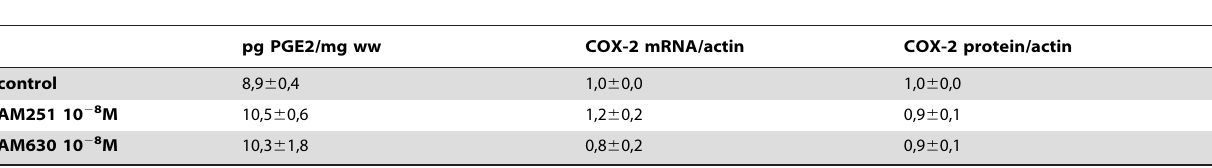
Table 6. Effect of cannabinoid receptors’ antagonists on the production of PGE2 and on the expression of COX-2.